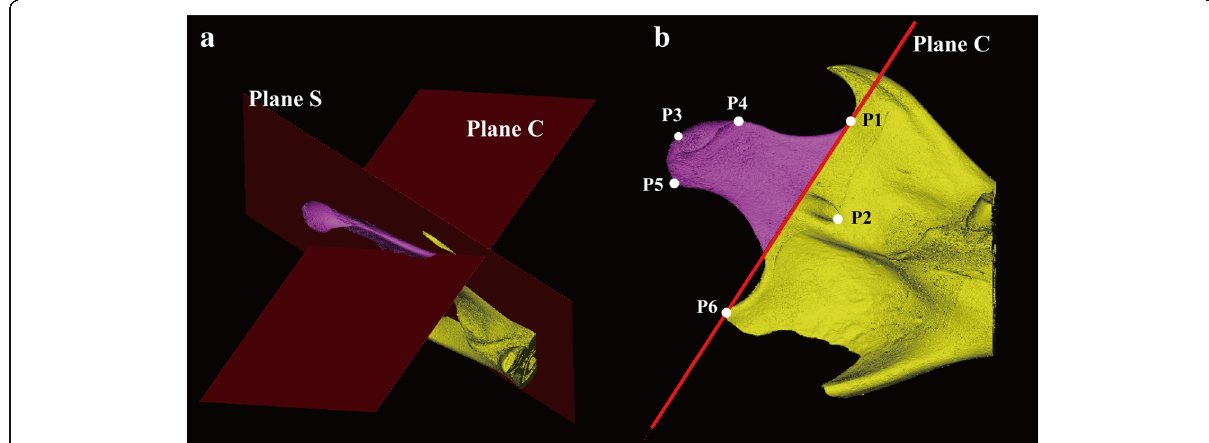
Fig. 3 Reference planes ( a ) and reference points ( b ). Plane S refers to a plane passing through P1, P2, and P6. Plane C refers to a plane normal to plane S, passing through P1 and P6. The condyle component was separated by plane C from the other part of the mandible. P1, sigmoid notch; P2, mandibular foramen; P3, condyle superior; P4, condyle anterior; P5, condyle posterior; P6,